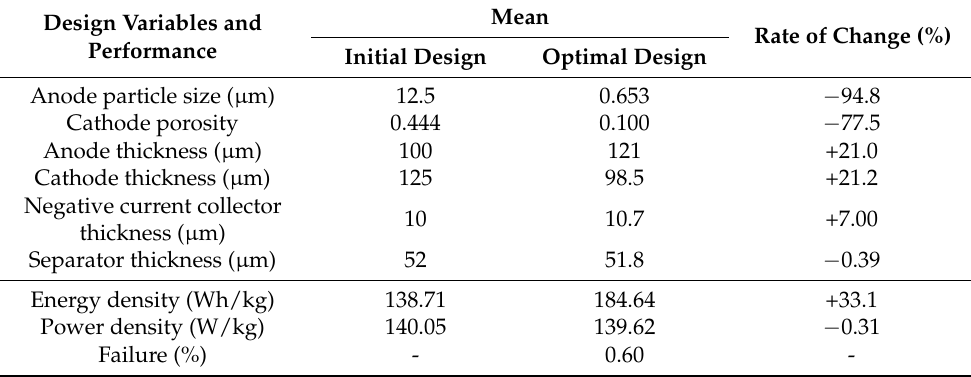
Table 4. Comparison of design variables and performance between initial and optimal